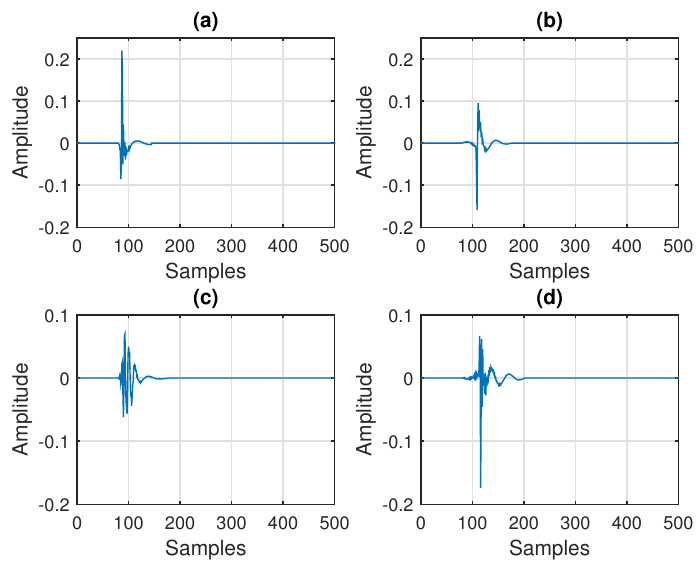
Figure 3. Impulse responses used in the first set of simulations from Section 6 (according to the G168 Recommendation [63]), with L = 500 and M = 4: ( a ) the first network echo path from [63], ( b ) the second network echo path from [63], ( c ) the fifth network echo path from [63], and ( d ) the sixth network echo path from from